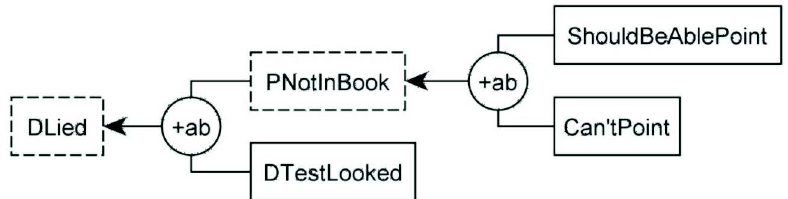
Figure 5. Argument Diagram of the Third Part of the Expert Opinion